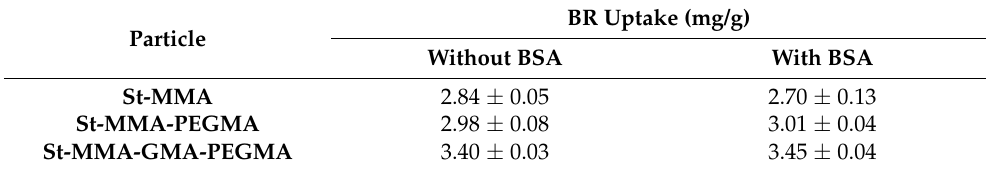
Table 5. Amount of removed bilirubin from PBS in particles with BSA wetted in ethyl lactate.